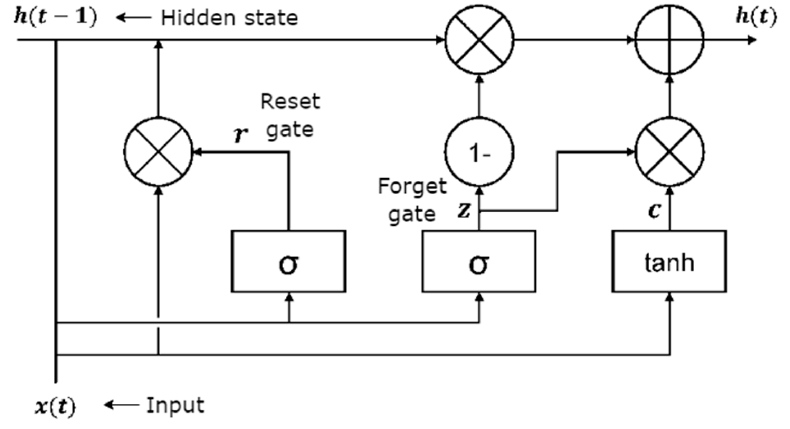
Figure 3. Architecture of GRU.